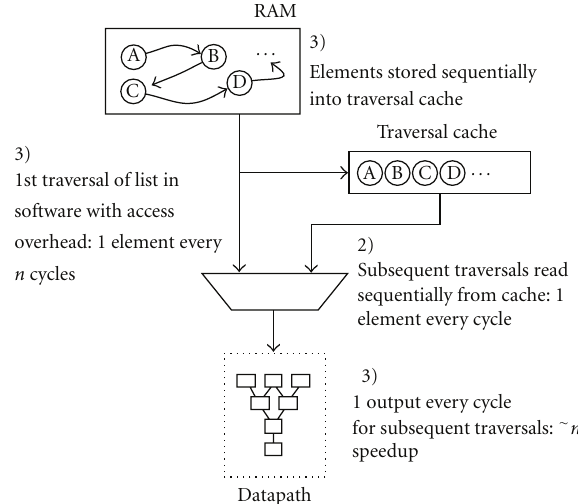
Figure 1: Conceptual idea of traversal caches , where repeated traversals of pointer-based structures are stored sequentially to improve memory bandwidth to custom